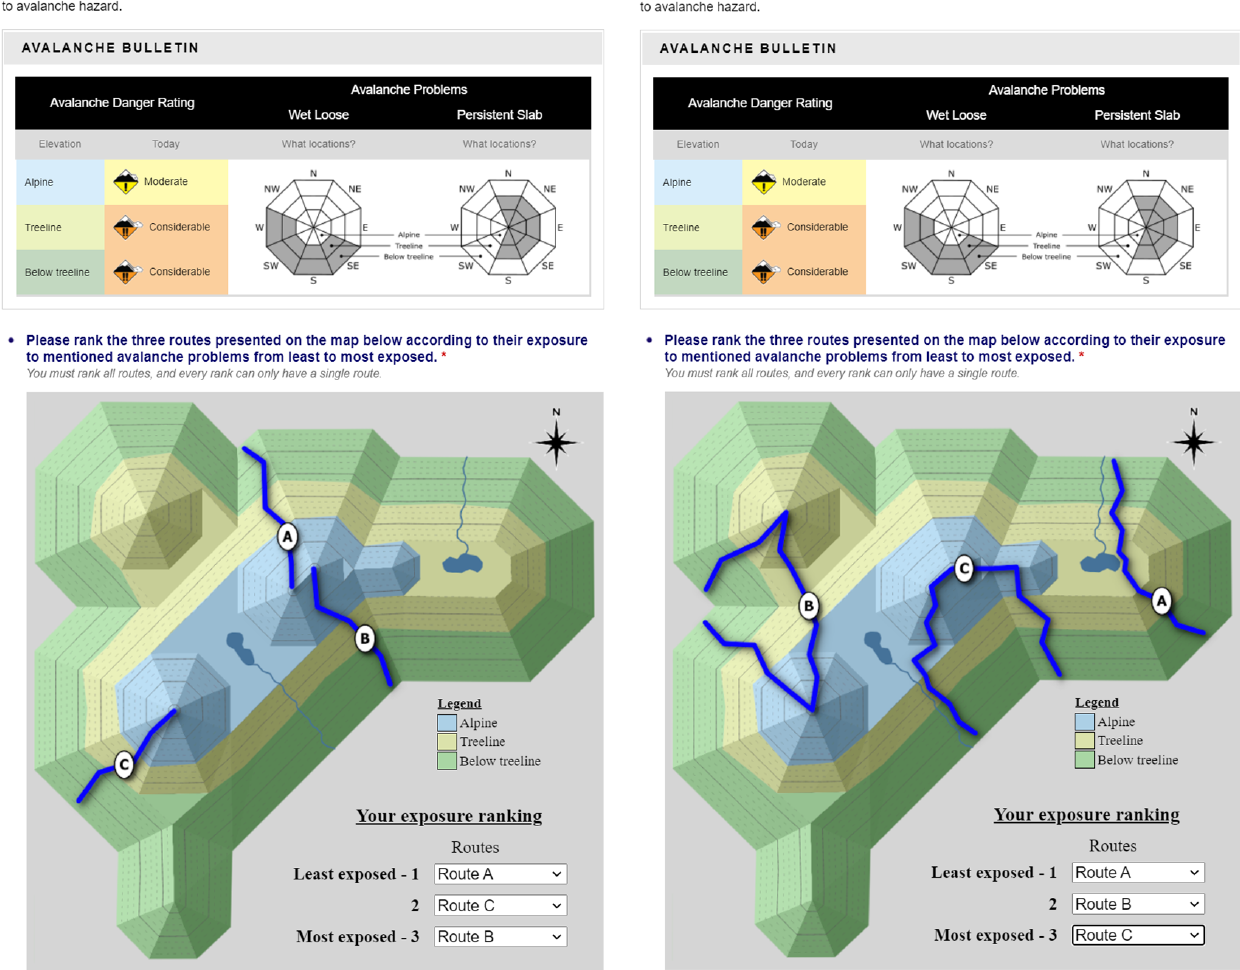
Figure 2. Examples of the route ranking exercises with the avalanche bulletin scenario and a custom-built topographic map, with three simple routes (a) and three complex routes (b)